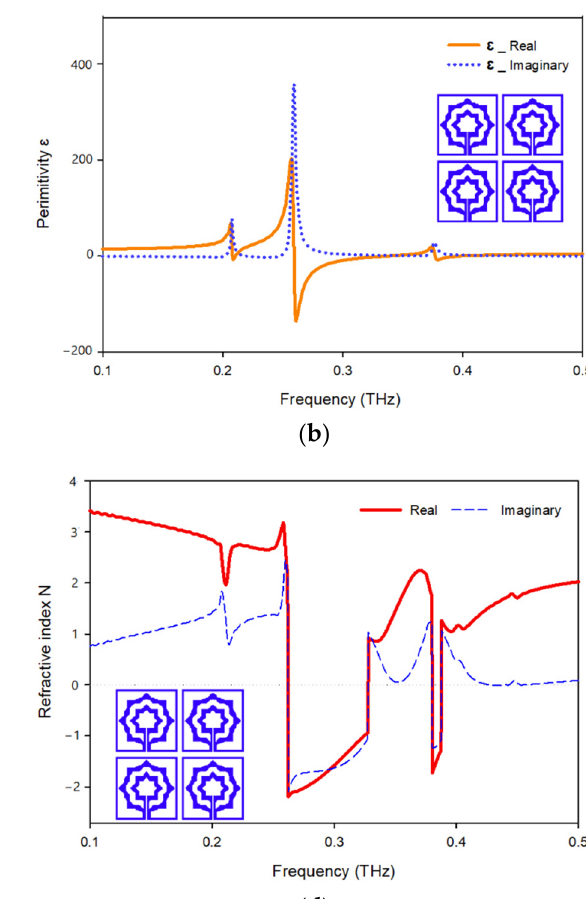
Figure 14. Analysis for 2 × 2 array: ( a ) current distribution; ( b ) magnetic field distribution; ( c ) electric field distribution for resonant frequency 0.25 THz.